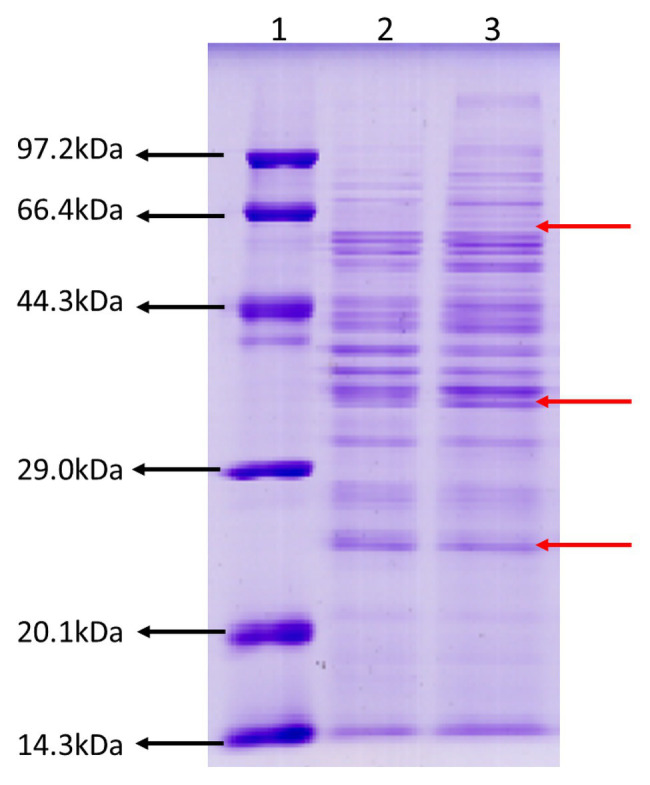
SDS-PAGE analysis of the Vibrio parahaemolyticus extracellular products. Protein molecular weight marker (Tiangen, Cat. No. DPP530S) (Lane 1), an extracellular product of Vibrio parahaemolyticus JHY20△ICE (Lane 2), and Vibrio parahaemolyticus JHY20 (Lane 3) cultured under the same condition at 37°C for 12h.